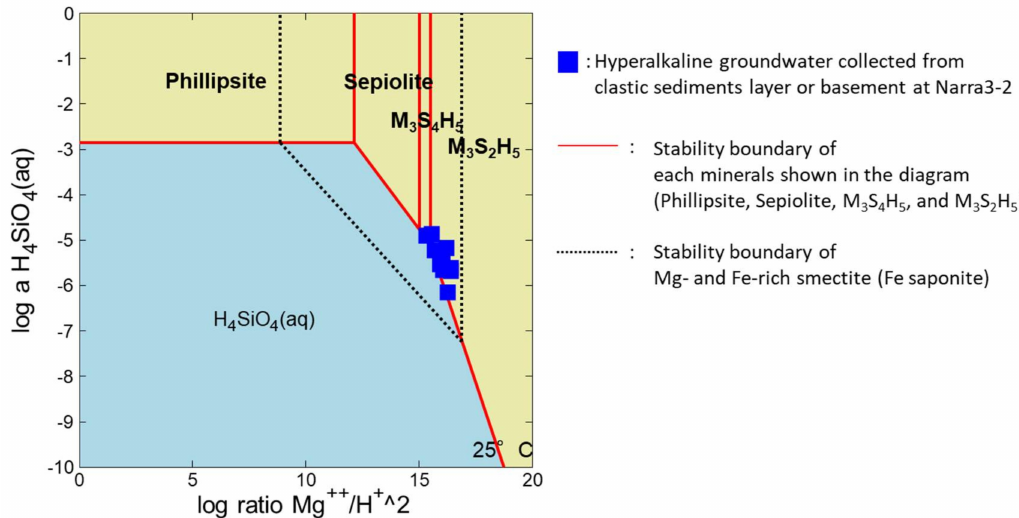
Figure 8. Phase diagram for the Mg-Si-Fe-Al-Na system. Blue squares represent hyperalkaline groundwater collected from the clastic sediment layer or basement at Narra3-2. Dotted lines show stability boundaries of Mg- and Fe-rich smectite (Fe saponite). M 3 S 4 H 5 : M-S-H (3MgO · 4SiO 2 · 5H 2 O); M 3 S 2 H 5 : M-S-H (3MgO · 2SiO 2 · 5H 2